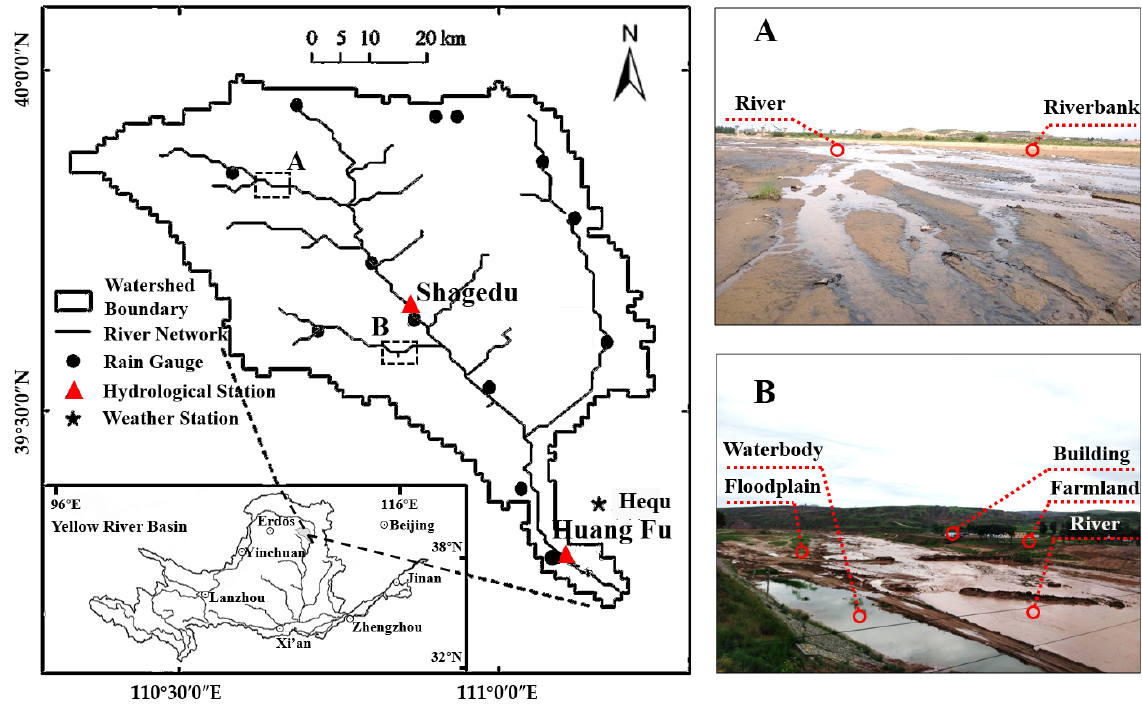
Figure 1. Schematic diagram of the Huangfuchuan River Basin. Photo ( A ) was taken in the upper reaches of the river basin. Photo ( B ) was taken in the middle reaches of the river basin.